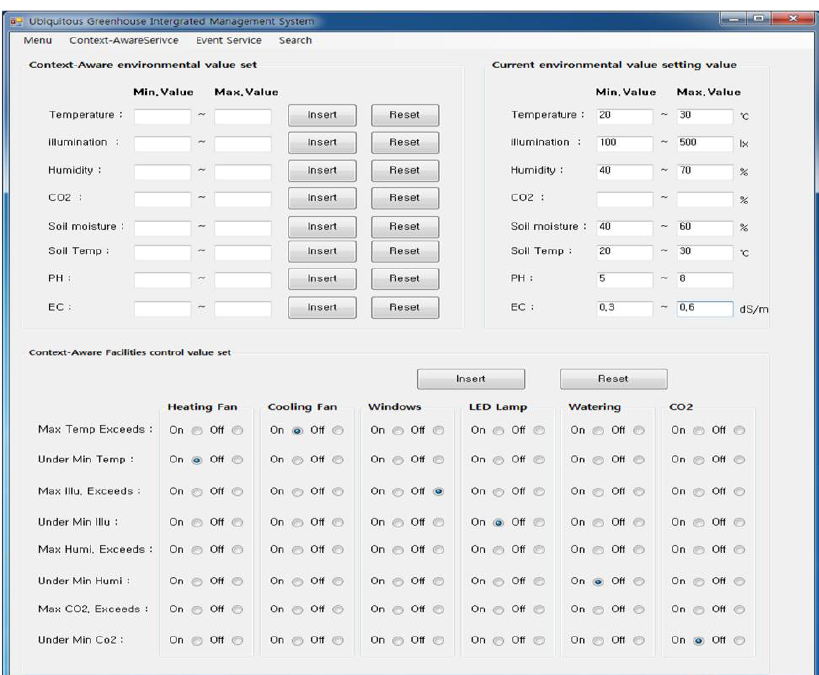
Figure 17. Context-aware service